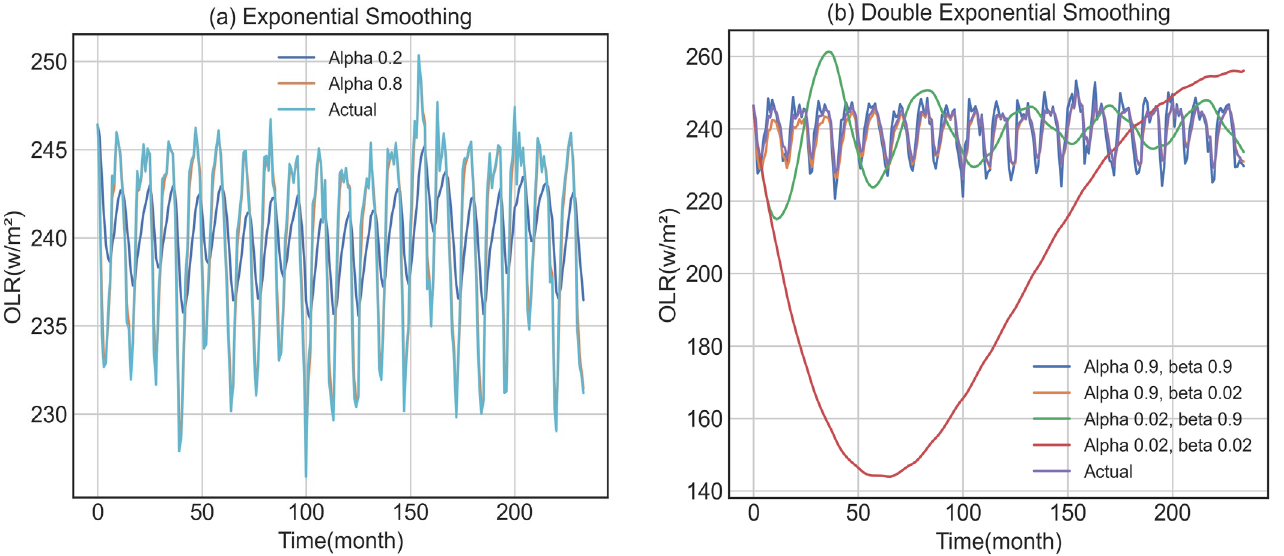
Figure 5. Exponential smoothing analysis: ( a ) exponential smoothing and ( b ) double-exponential smoothing .